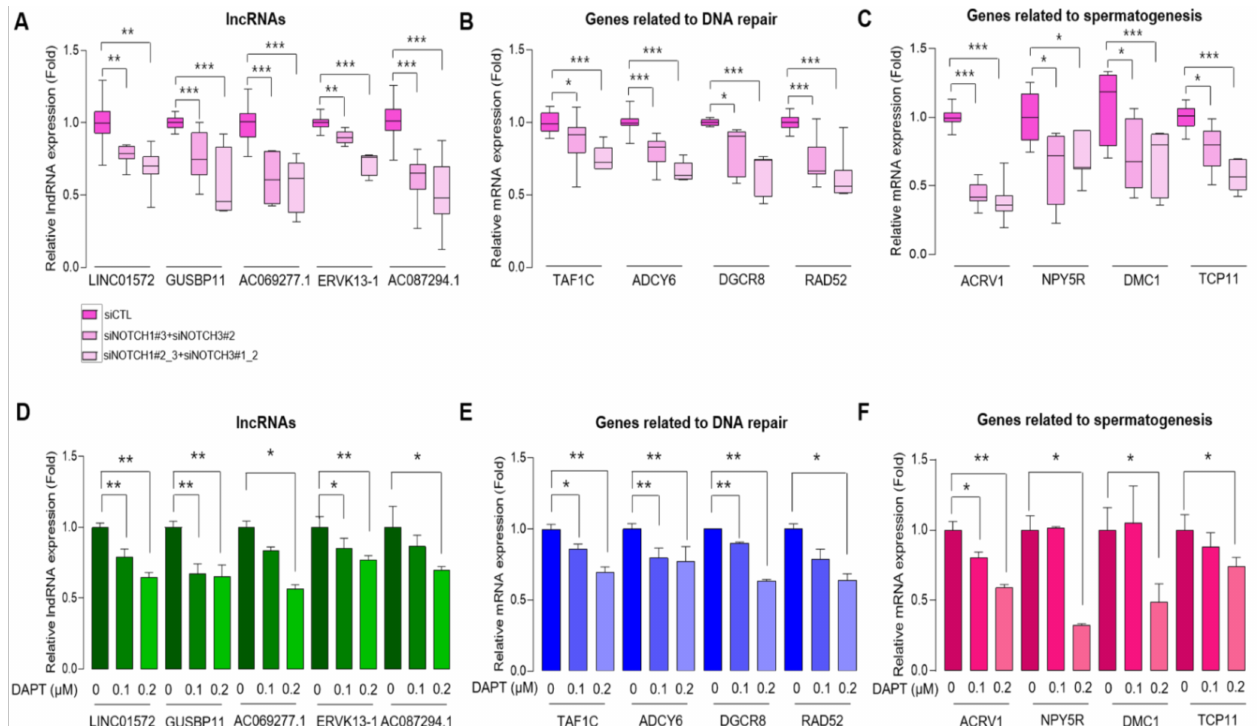
Figure 3. Validation of in silico analysis and transcriptome data in HGSC cell line. Results of qRT- PCR for mRNAs of representative Notch-related lncRNAs ( A ), DNA repair-related targets ( B ), and Spermatogenesis-related targets ( C ) in OVCAR3 cells transfected with control siRNA (siControl) or NOTCH 1/3 siRNAs as indicated for 48 h. Comparisons of the relative expression of representative Notch-related lncRNAs ( D ), genes related to DNA repair ( E ), and spermatogenesis ( F ) in OVCAR3 cells following treatment with DAPT for 48 h. Data is shown as mean ± SD and p -values were calculated by two-tailed Mann–Whitney U-test. All experiments were repeated three times, and each experiment was performed in triplicate. * p < 0.05, ** p < 0.01, *** p < 0.001. Abbreviations: CTL, Control; TAF1C, TATA-Box Binding Protein Associated Factor; ADCY6, Adenylate Cyclase Type 6; DGCR8, DiGeorge Syndrome Critical Region Gene 8; RAD52, DNA Repair Protein RAD52 Homolog; ACRV1, Acrosomal Vesicle Protein 1; NPY5R, Neuropeptide Y Receptor Y5; DMC1, DNA Meiotic Recombinase 1; TCP11, T-Complex 11, DAPT: N-[N-(3,5-difluorophenacetyl)-L-alanyl]-S- phenylglycine t-butyl